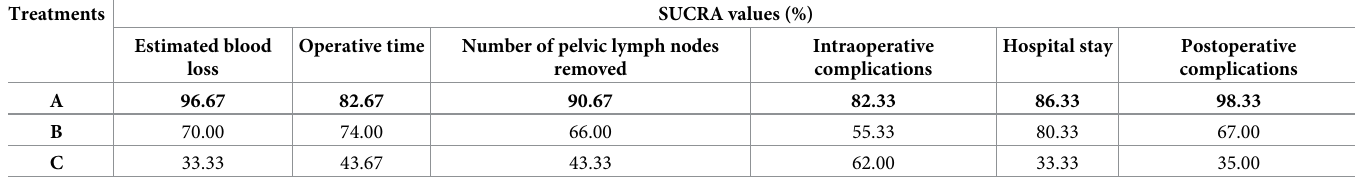
Table 4. SUCRA values of three treatment modalities under six endpoint outcomes.